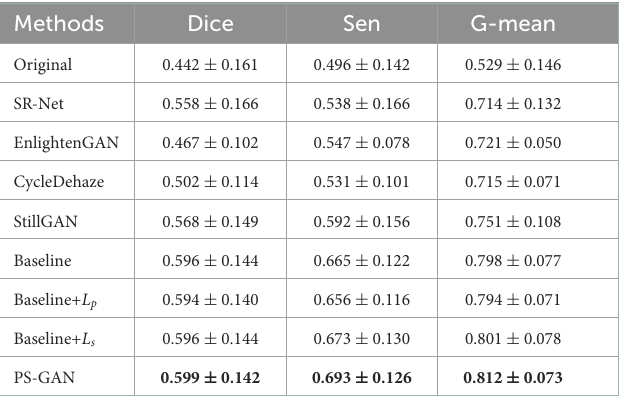
TABLE 5 Vessel segmentation performance on original images in AS-OCTA dataset, and their de-striping results of SR-Net and re-enhanced versions via different methods, and ablation study of our